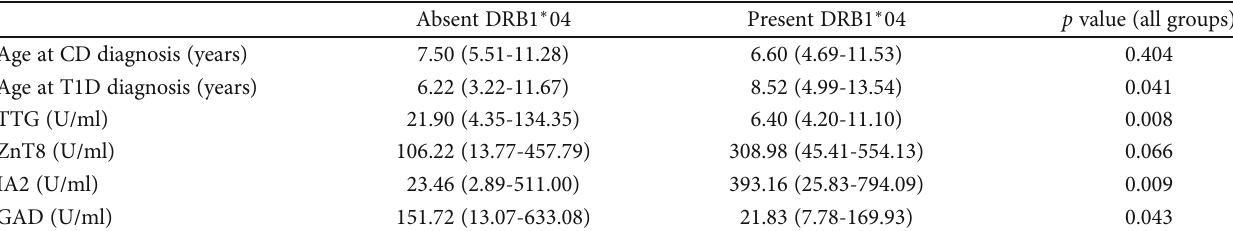
Table 3: The association of DRB1 ∗ 04 allele with clinical course of both diseases — all groups.